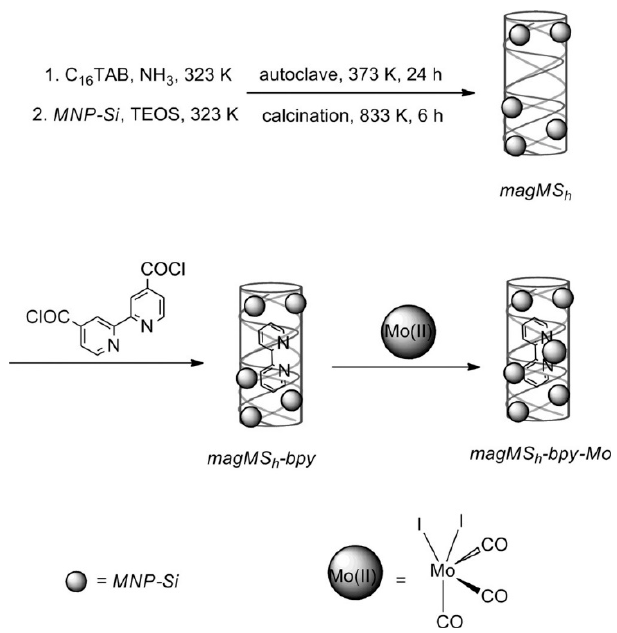
Figure 62. Synthesis and derivatization of magMS h material with bipyridine ligand and Mo(II) center. Reproduced with permission from [164]. Copyright 2017 WILEY-VCH Verlag GmbH & Co. KGaA,